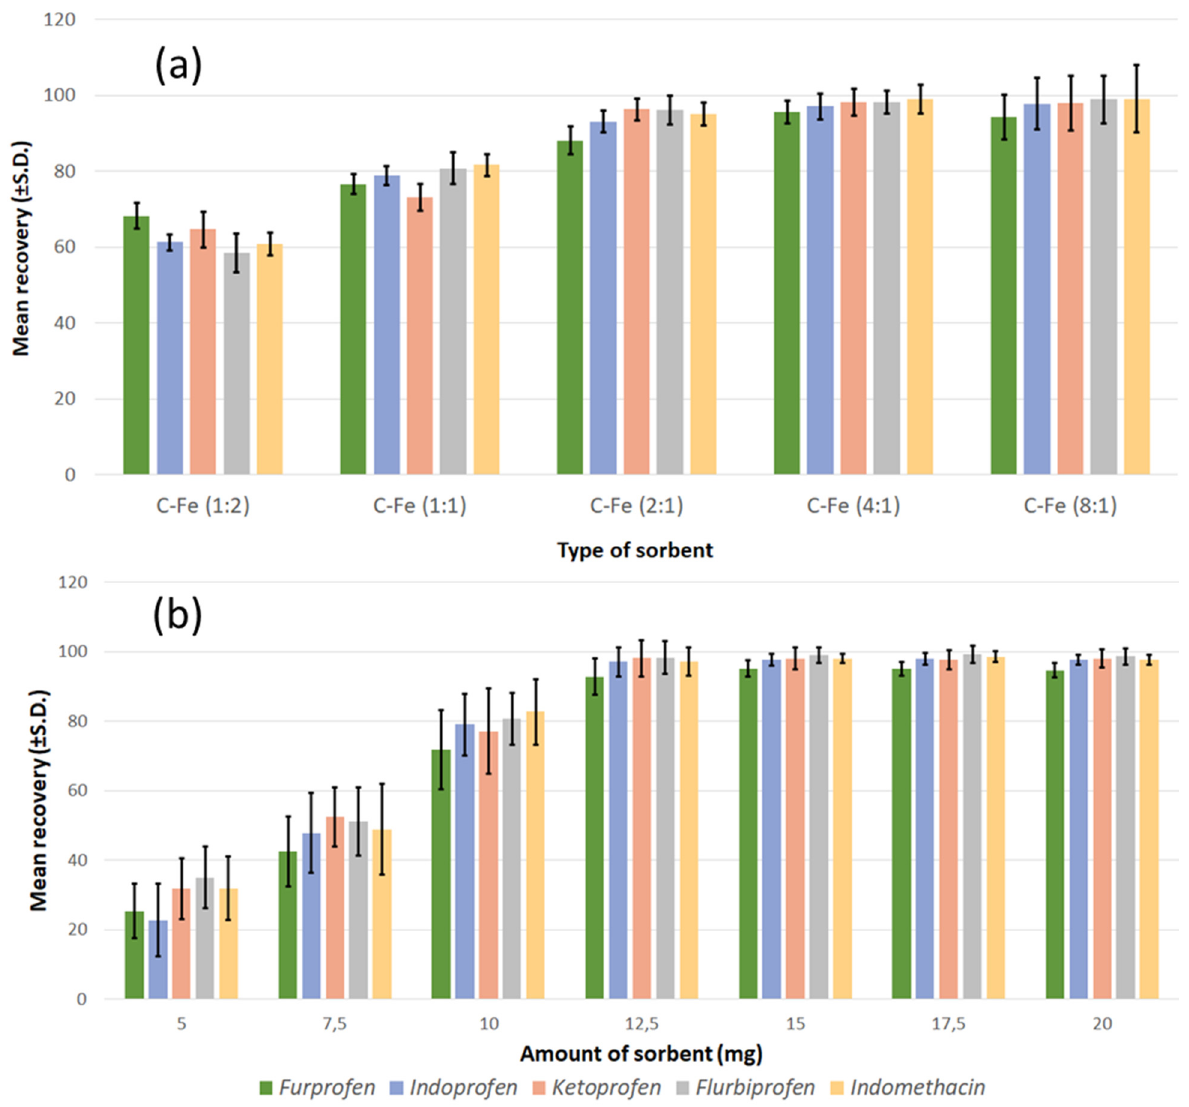
Figure 6. ( a ) Effect of sample type and ( b ) effect of the amount of adsorbent on the extraction efficiency of the analytes in the process of MSPE.